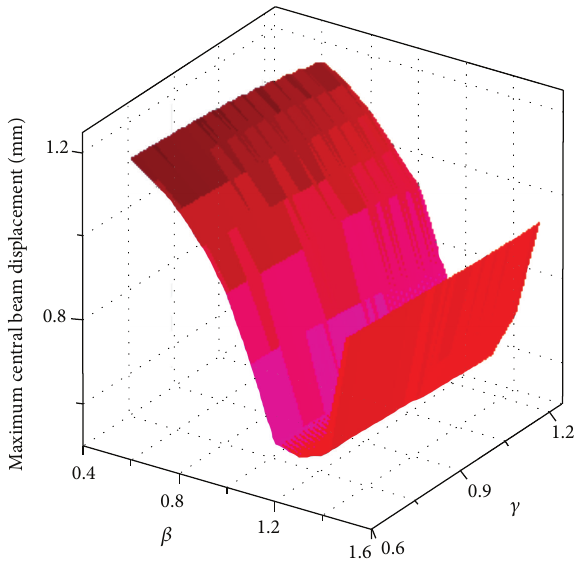
Figure 10: The maximum central deflection of the beam against the order of the beam’s fractional derivative and the fractional derivative of the absorber ( 𝛽,𝛾